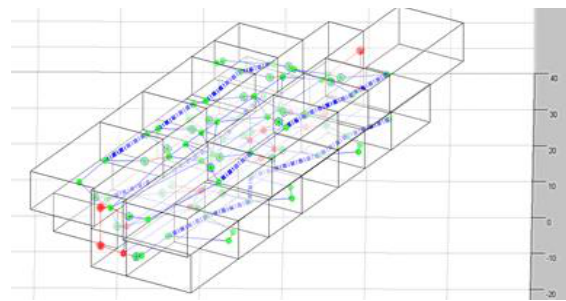
Figure 10. Simplified data model by Jamali et al.